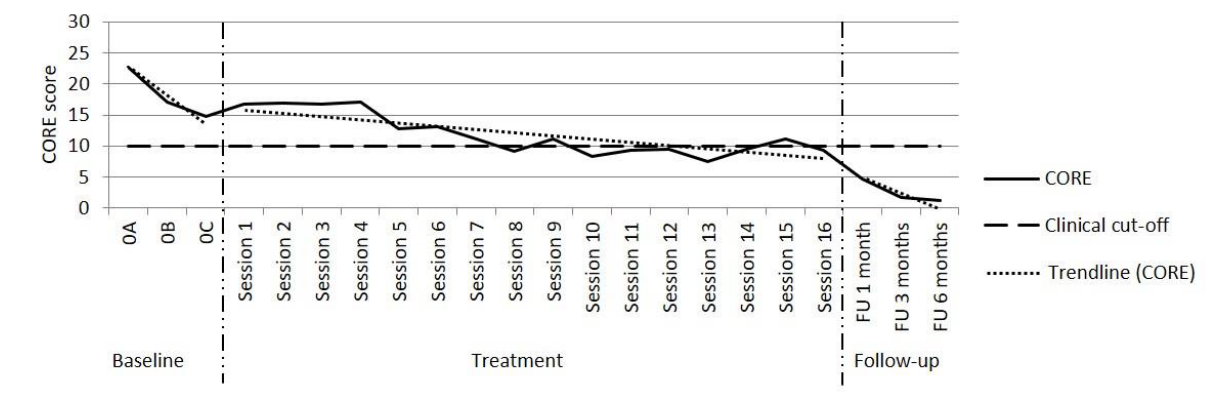
Figure 1: Giorgio’s weekly depressive (PHQ-9) score